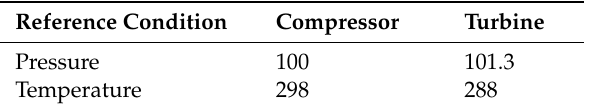
Table 1. Reference conditions for conducting turbocharger